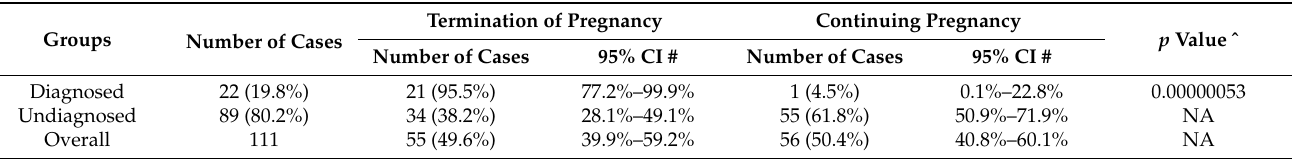
Table 3. Impact of genetic diagnoses on pregnancy